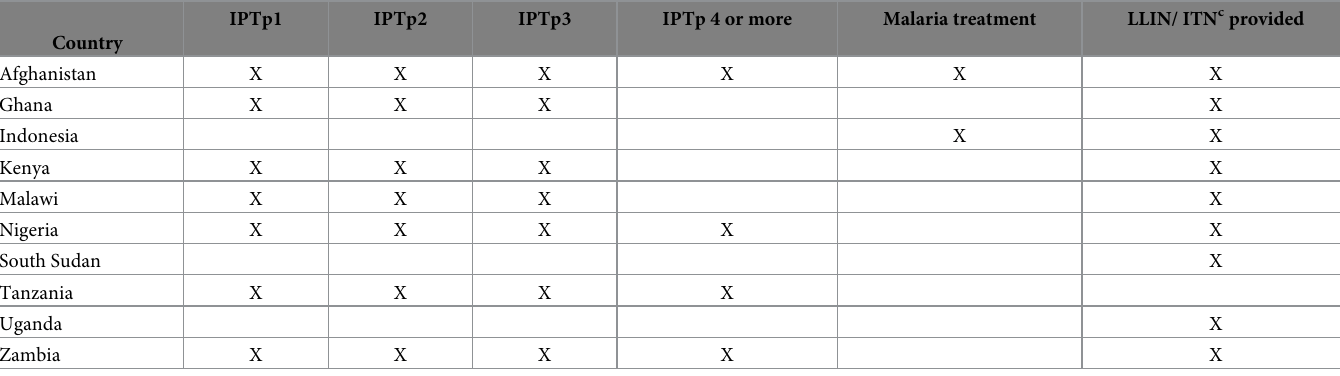
Table 3. IPTp doses, malaria treatment and bed